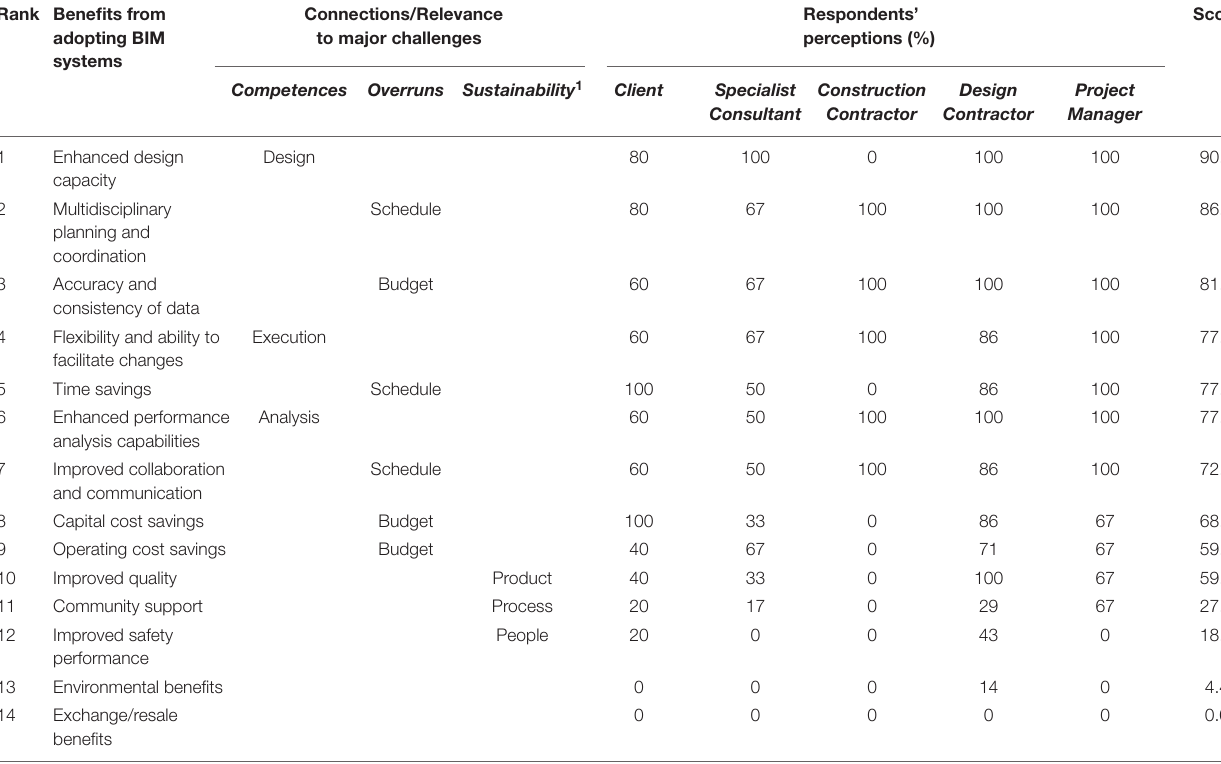
TABLE 9 | Major challenge oriented benefits identified upon BIM adoption in megaproject